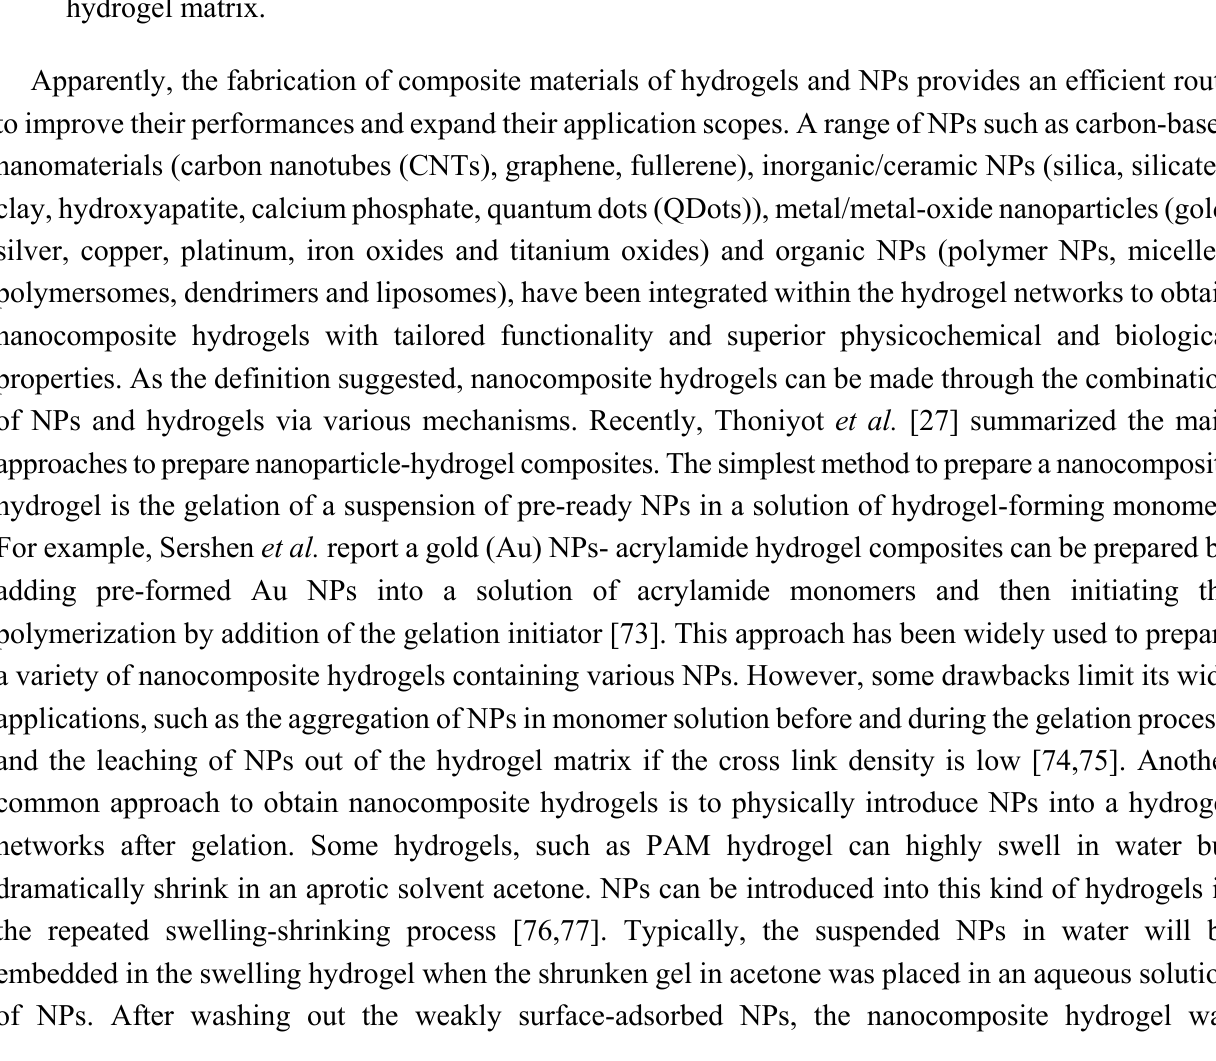
Figure 3. Schematic illustration of typical nanocomposite hydrogels from hydrogels and drug-loaded nanoparticles (NPs). NPs were non-covalently or covalently immobilized in a hydrogel